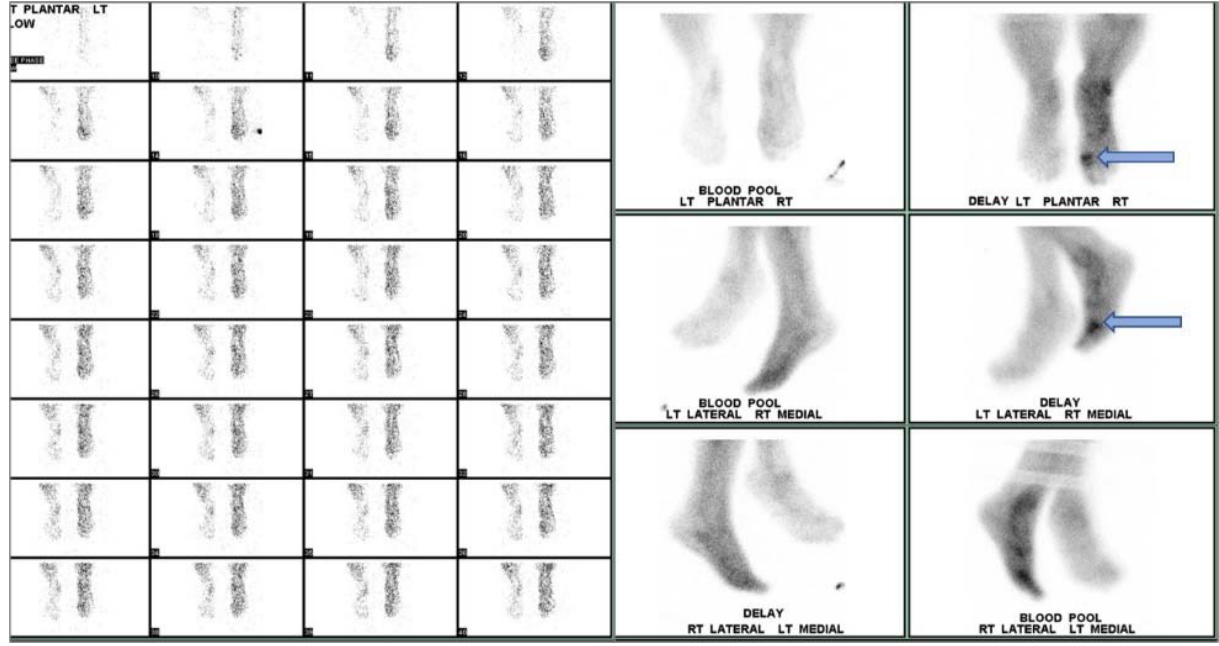
Figure 6. Three-phase bone scan of an individual with confirmed DFI. Cellulitis is visualized in the right foot with OM in the first metatarsophalangeal region ( arrow ).